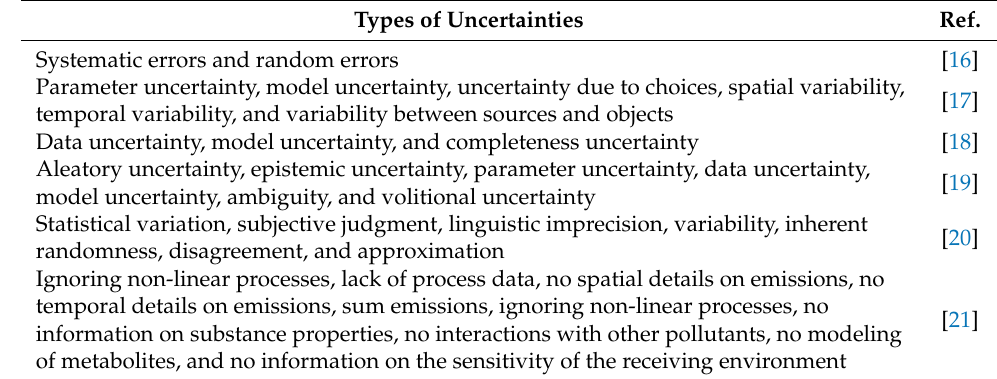
Table 1. Classification of uncertainties according to different authors. Types of Uncertainties Ref. Systematic errors and random errors Parameter uncertainty, model uncertainty, uncertainty due to choices, spatial variability, temporal variability, and variability between sources and